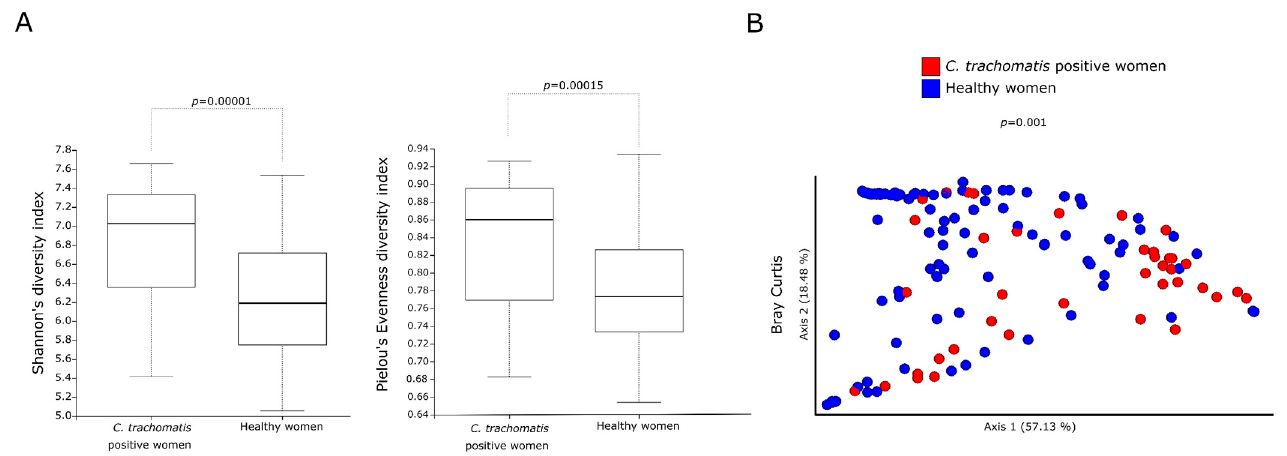
Figure 1. Alpha- and beta-diversity indexes of the predicted metabolic pathways between C. trachomatis -positive women and healthy controls. ( A ) Shannon’s and Pielou’s evenness indexes, used as a measure of alpha-diversity within groups; ( B ) Principal coordinate analysis of Bray–Curtis index, used as a measure of beta-diversity between groups. Each circle represents the predicted metabolic pathways in the cervicovaginal microbiota of each study subject.